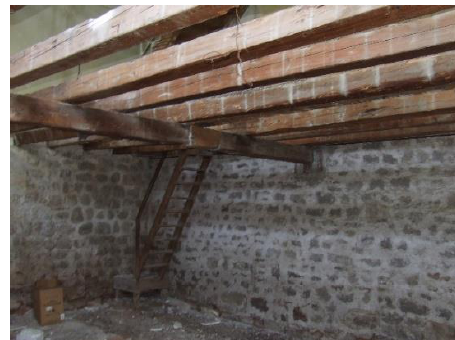
Figure 16. Typical gable roof. Transversal beams had the function of tie-rods.